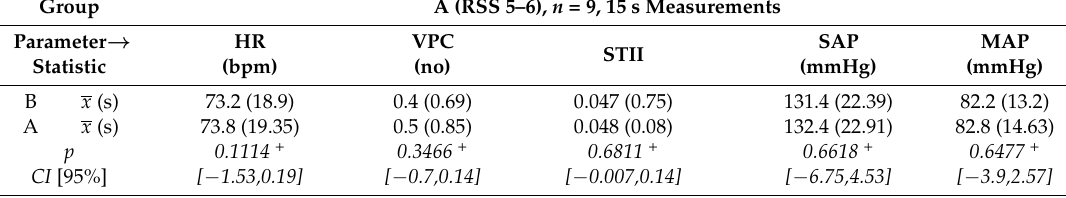
Table A1. Main descriptive statistics and before/after comparison (inferential statistics, in italics) of the measurements during suction in 15 s measurements for the two groups (A upper table and B down table): HR—heart rate, VPC—ventricular premature contractions (number), STII—electrocardiographic ST wave deviation in II lead, SAP—systolic arterial pressure, MAP—mean arterial pressure, DAP—diastolic arterial pressure, RR—respiratory rate, and EDA parameters (ArHP, ArSP, NFSC, AvRT, AvP, AUC, SC). Statistics are deliberately displayed with decimals, for accuracy, even though in some cases clinical significance is